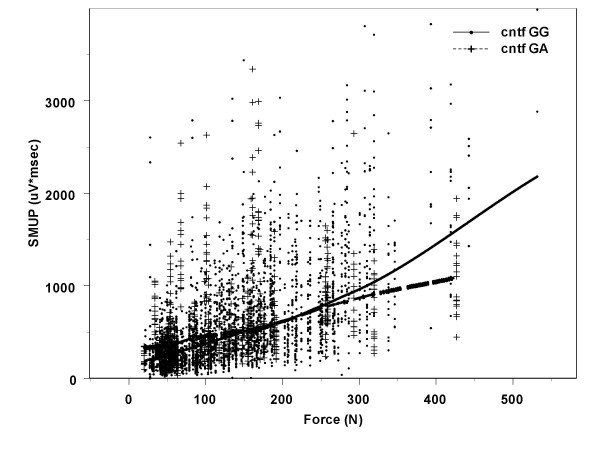
Relationship between knee extension force and motor unit size (SMUP area) for CNTF GG and GA genotypes. Data represent individual measurements with a loess regression line for each genotype. Statistical analyses are given in Table 3.